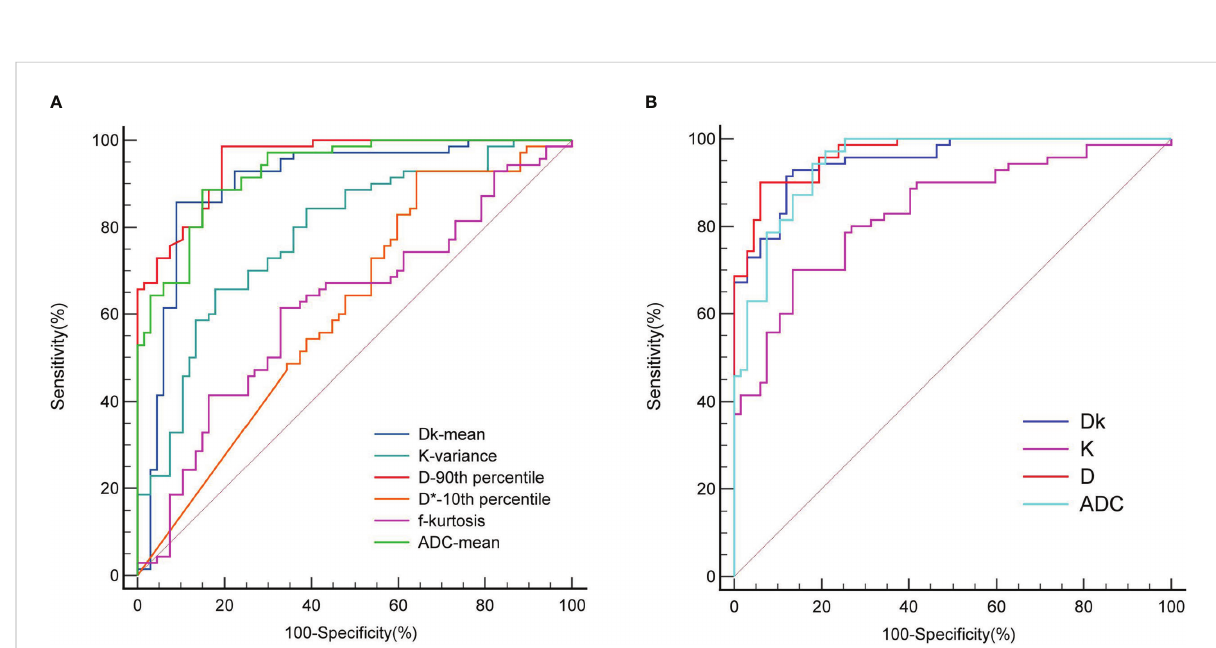
FIGURE 3 ROC curve for differentiating benign and malignant SPL by whole-lesion histogram parameters. (A) is the parameter ROC of single whole-lesion histogram, (B) is the multi-parameter ROC of combined whole-lesion histogram. D* is one of the parameters of